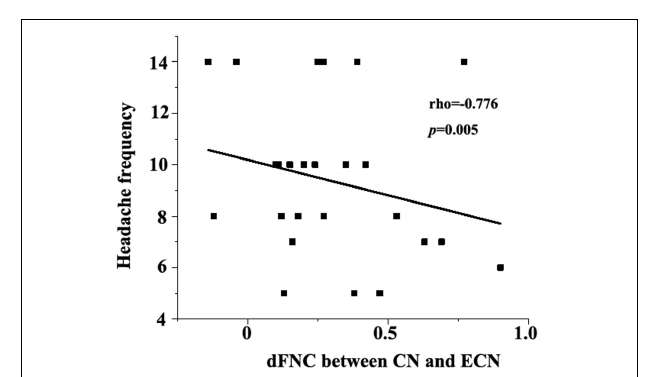
FIGURE 4 | Negative correlation between dFNC (CN-ECN) and headache frequency (rho = − 0.776, p =